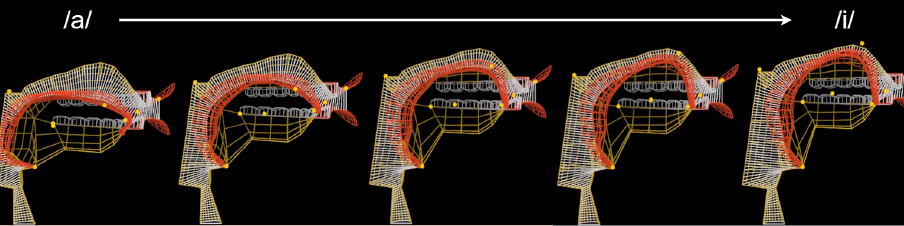
Figure 9. Vocal tract controlled by the learned policy while